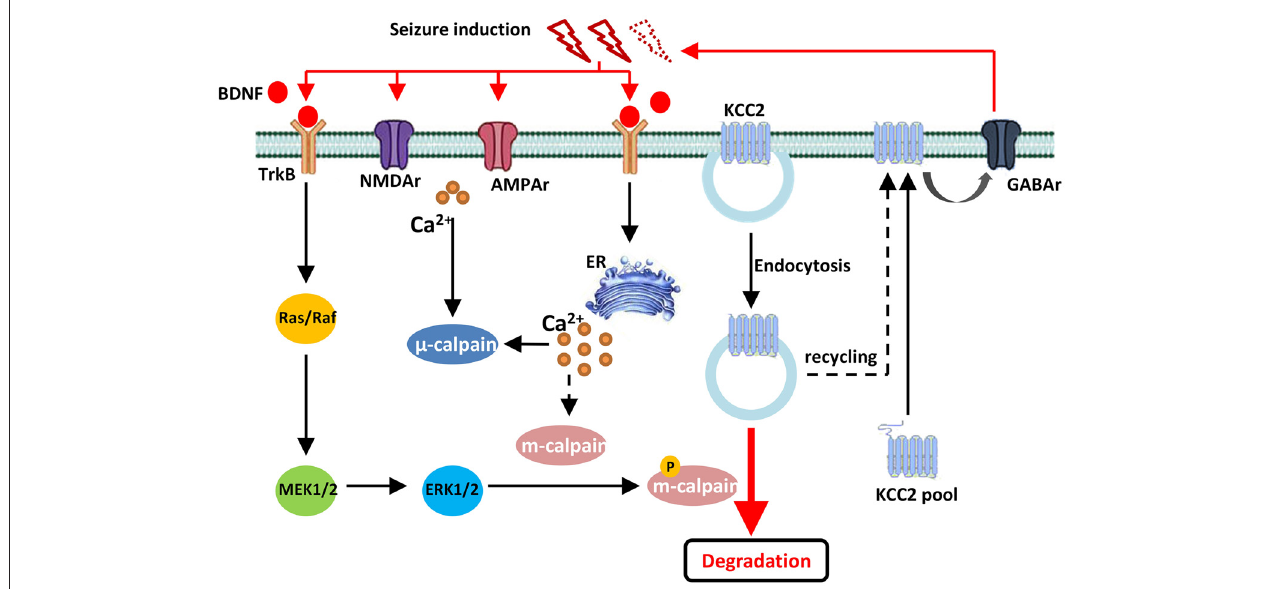
FIGURE 6 | Drawing diagram showing the cellular mechanism of m-calpain phosphorylation involvement in seizure onset induced KCC2 down regulation. Both endocytosis and TrkB-MAPK/ERK–m-calpain pathways regulated KCC2 level in neurons.